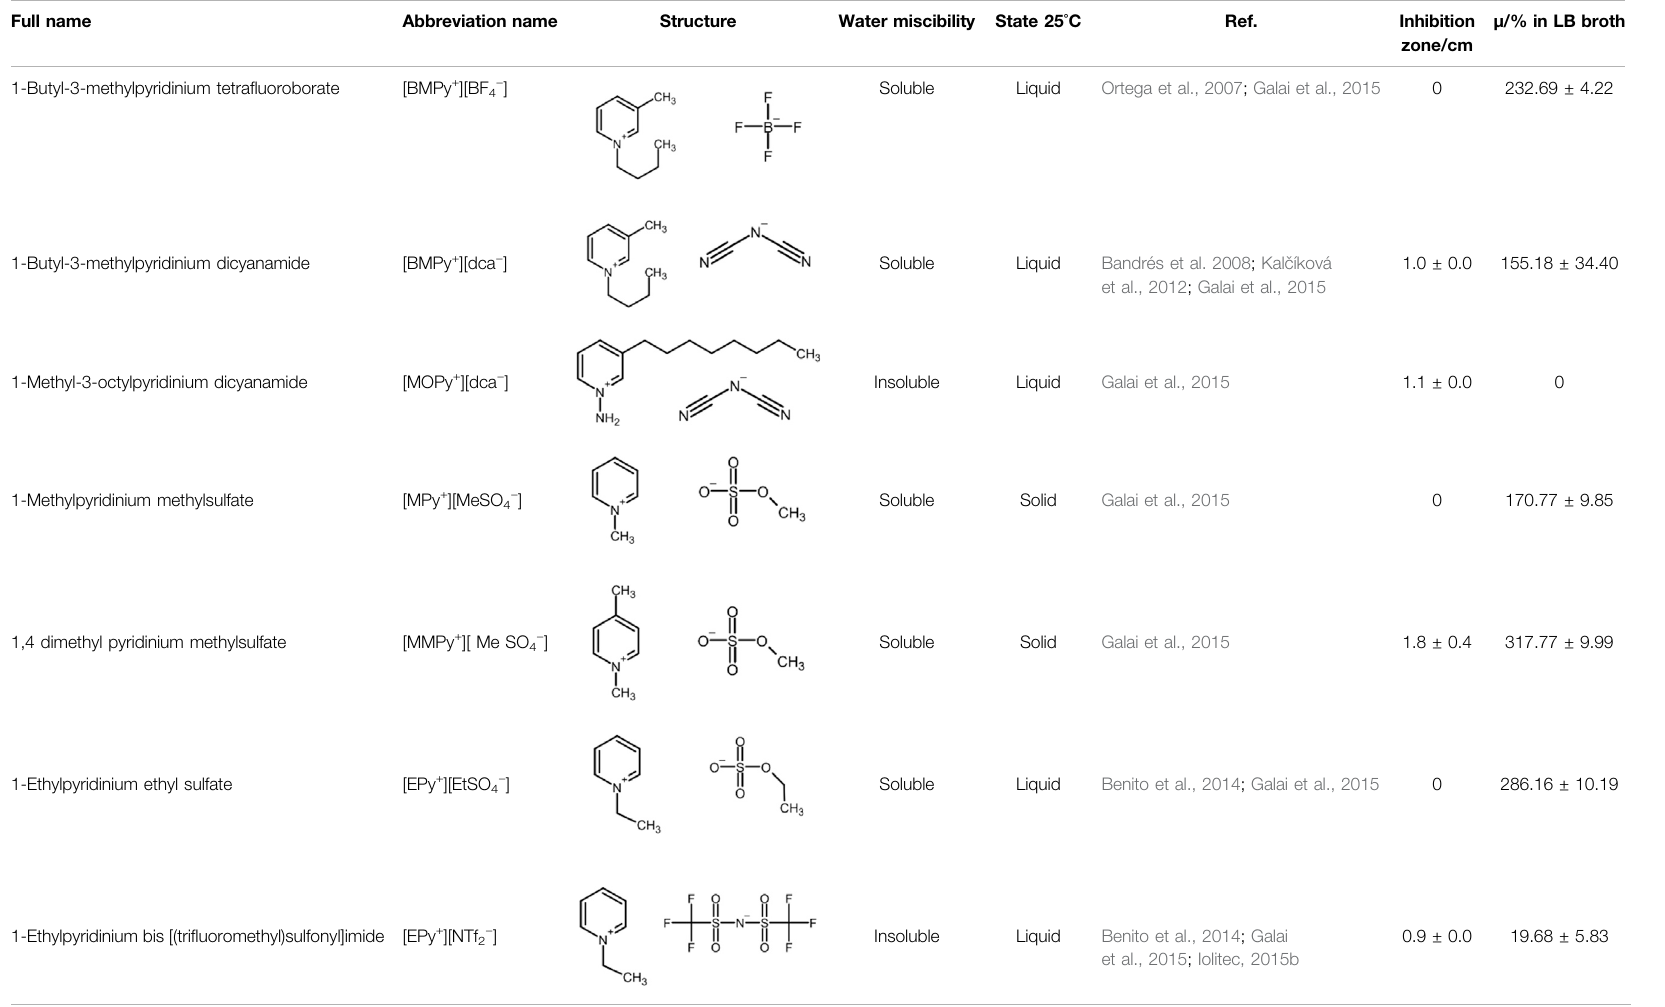
TABLE 2 | Pyridinium-based ionic